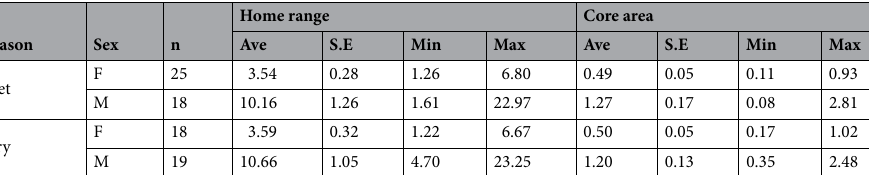
Table 1. Average (Ave.) seasonal home range and core area sizes (km 2 ) for wild pigs at Buck Island Ranch, FL. Home range information was provided for all wet and dry seasons. Home range information was divided by sex (F: female, M: male) with sample size (n), standard error (S.E.), minimum values (Min.), and maximum values (Max.)